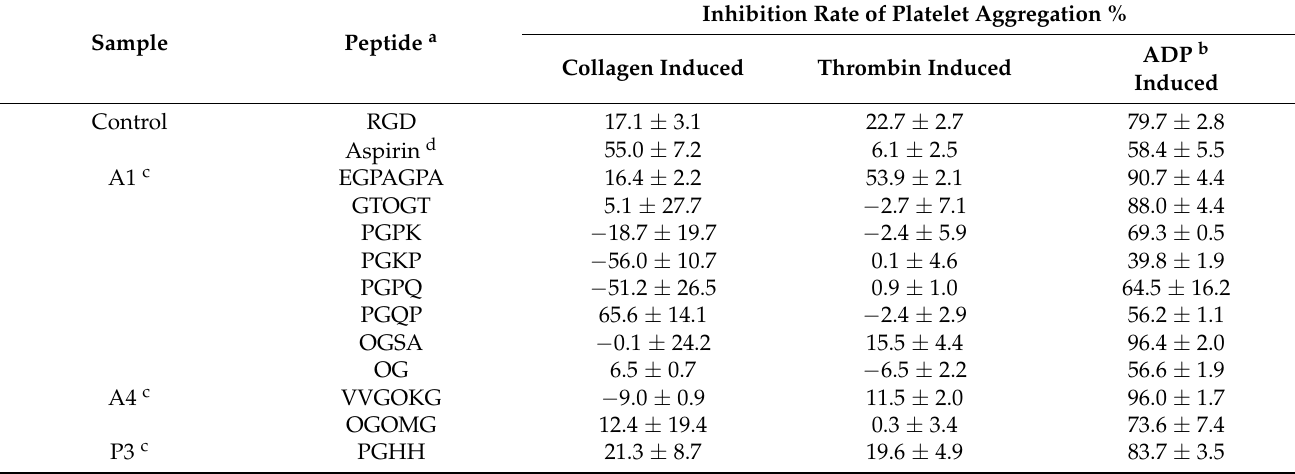
Table 1. Effect of 11 identified peptides on inhibiting platelet aggregation induced by different activators.